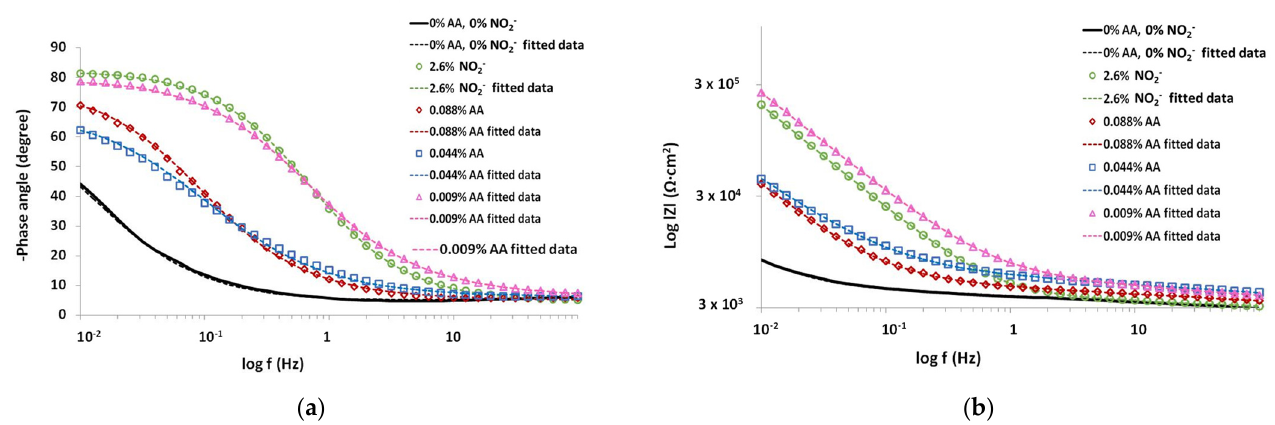
Figure 6. Bode plots of chloride-contaminated mortars, 2% of Cl − with 0.088, 0.044 and 0.009% of AA and 2.6% of NO 2 − ( a ) logarithmic frequency vs. phase angle; ( b ) logarithmic impedance modulus vs. log